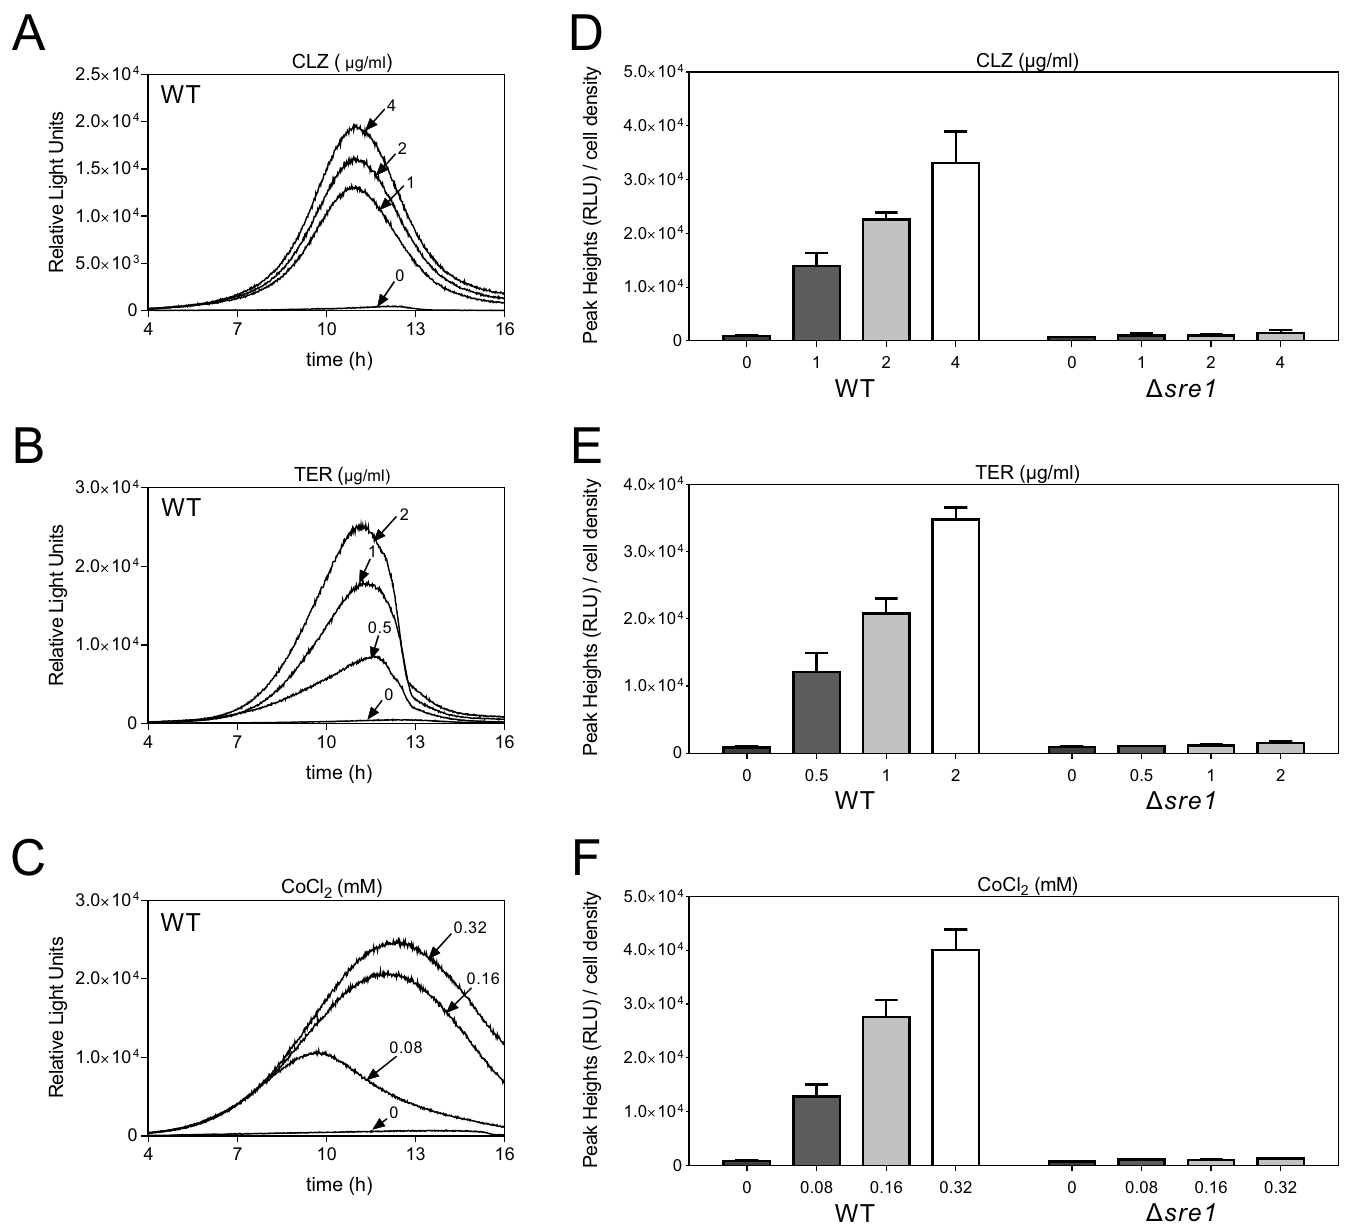
Fig 3. The luciferase activity expressed from the chromosome-borne 3 × SRE2::luc (R2.2) wild-type and Δ sre1 cells. (A) CLZ (1 μ g/ml to 4 μ g/ml), (B) TER (0.5 μ g/ml to 2 μ g/ml) and (C) CoCl 2 (0.08 mM to 0.32 mM) induced a marked increase in Sre1 transcriptional activity. Wild-type chromosome-borne 3 × SRE2::luc (R2.2) cells were cultured and assayed as described in materials and methods. Y-axis values are the relative light units (RLU) of each sample. The data shown are representative of multiple experiments. (D-F) An extremely low response upon stimulation by CLZ (1 μ g/ml to 4 μ g/ml), TER (0.5 μ g/ml to 2 μ g/ml) and CoCl 2 (0.08 mM to 0.32 mM) was examined in Δ sre1 chromosome-borne cells. The Δ sre1 chromosome-borne cells were cultured and assayed as described in Fig 3A–3C. Y-axis values are the relative light units (RLU) of peak height normalized to the cell density (OD660) of each sample at the peak time. The data were averaged from three independent experiments, and each sample was done in triplicate. Error bars indicate means (n = 3) ±